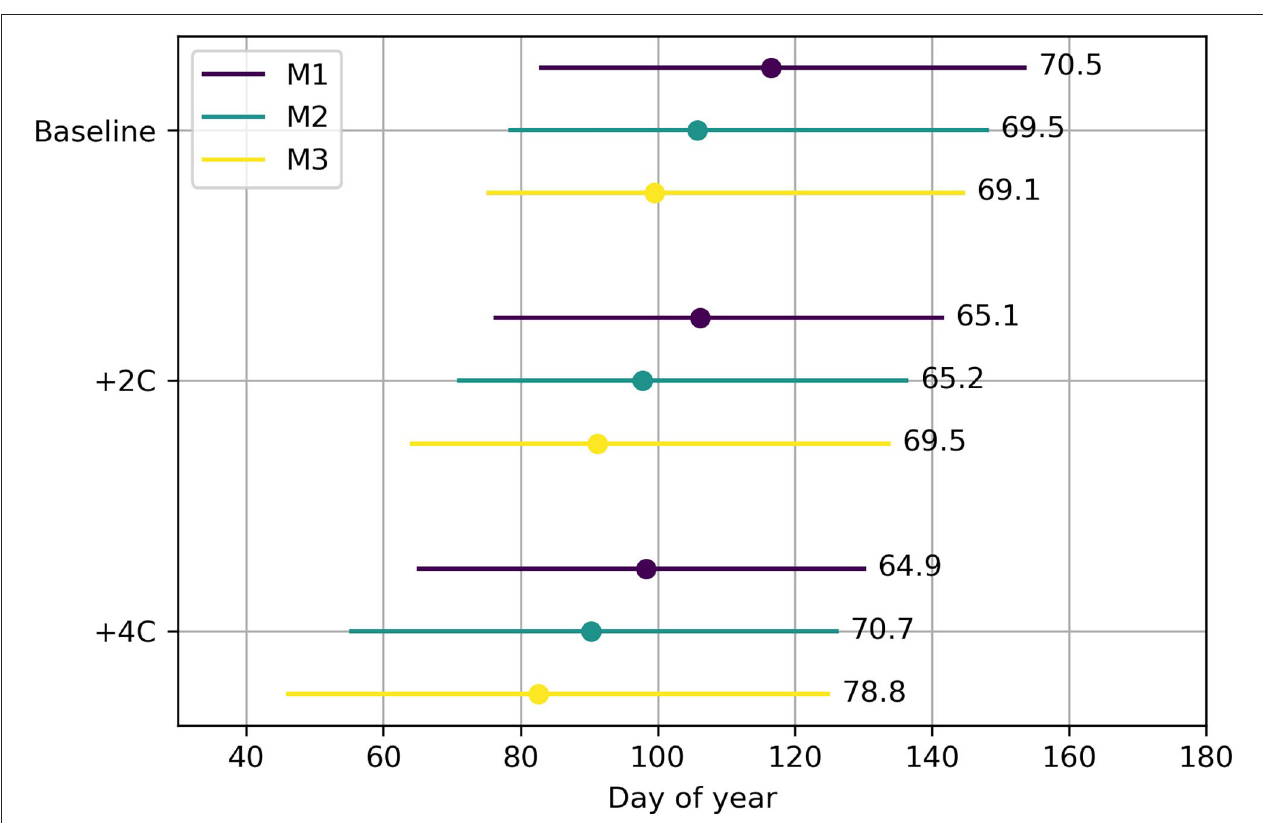
FIGURE 9 | Summary of changes in melt season metrics. Horizontal lines indicate the melt season onset, center of snowmelt mass [large symbol] and end of melt season for the base case, + 2 and + 4 ◦ C temperature scenarios and 50 basin hypsometries. Numbers following the lines represent the mean duration of the snowmelt